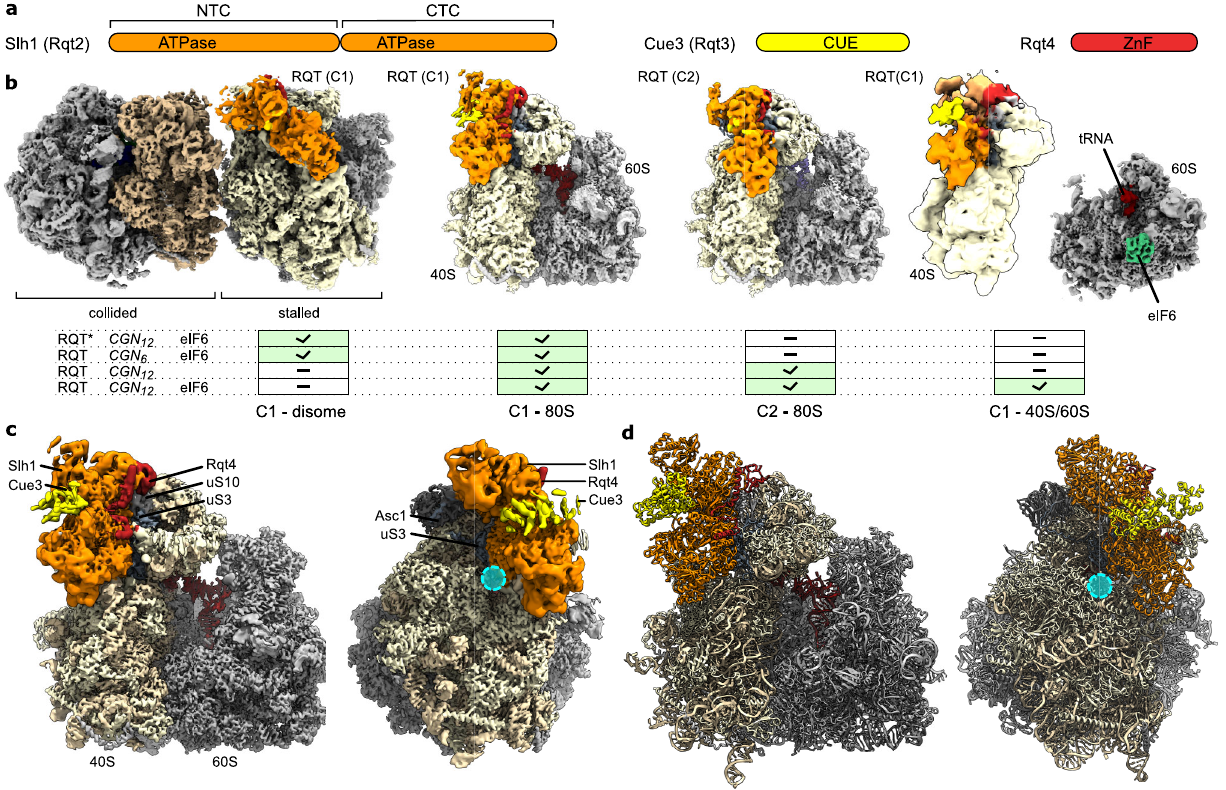
Fig. 2 | Cryo-EM analysis of RQT-ribosomes complexes. a Scheme outlining components of the trimeric RQT complex. NTC, CTC = N-terminal and C-terminal cassette, CUE = Coupling of Ubiquitin to ERdegradationdomain, ZnF = zinc- fi nger domain. b Composite cryo-EM maps of RQT-containing ribosomal particles found incryo-EManalysesofpre-splittingreactions(shortmRNAorATPasede fi cientSlh1, RQT*) and post-splitting (long mRNA and wt Slh1) reactions. Occurrence of